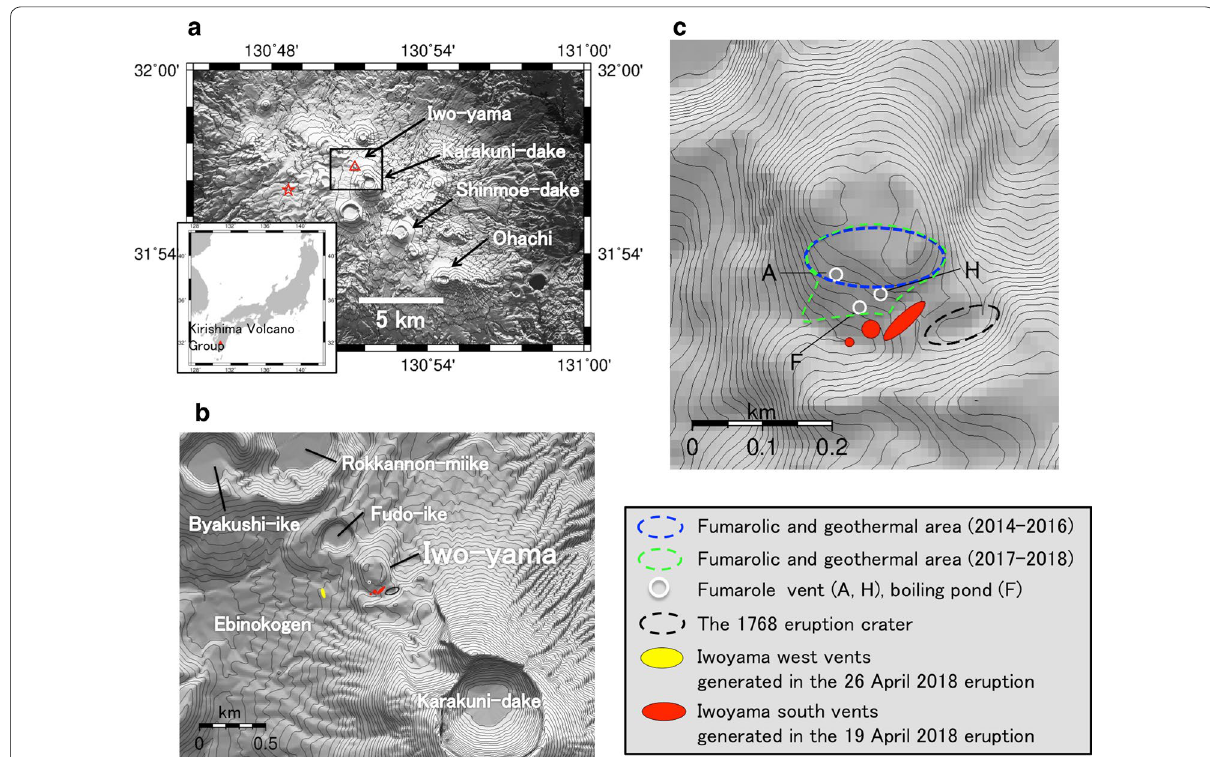
Fig. 1 Maps around Iwo-yama. a Map of Kirishima Volcano Group. The red triangle shows the location of Iwo-yama. The red star shows the location of a magma chamber at 7-km depth (Japan Meteorological Agency 2019). The inset rectangle indicates a local region corresponding to the region of b . b Map around Ebino Plateau, including Iwo-yama. c Close view of Iwo-yama. The blue and green dashed lines indicate a geothermal area with jet fumarole vents and mud pots (white circles) manifested during 2014–2016 and 2017–2018,